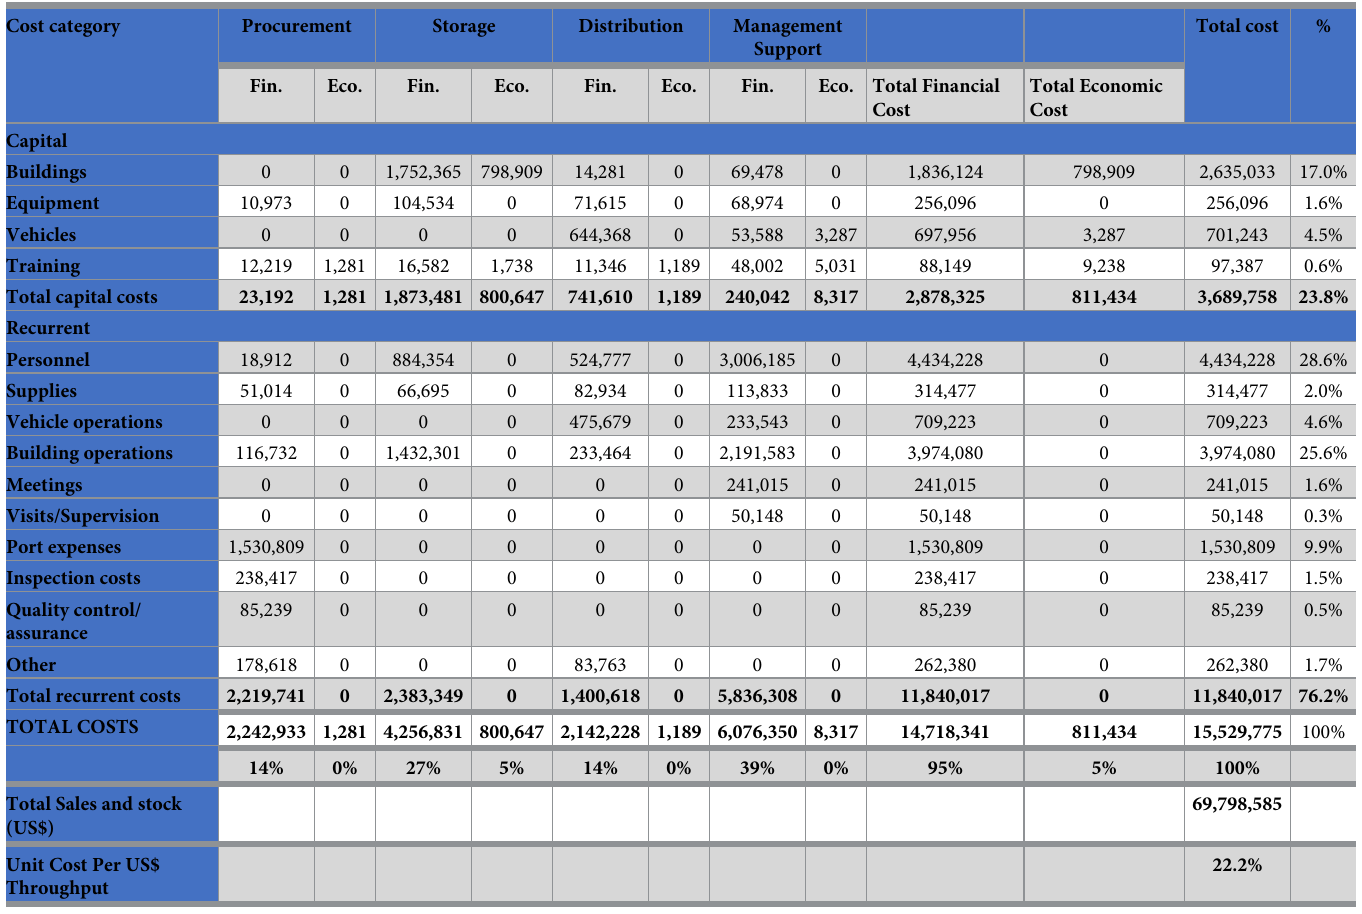
Table 2. Average annual costs of running the supply chain at the central medical stores department (2020